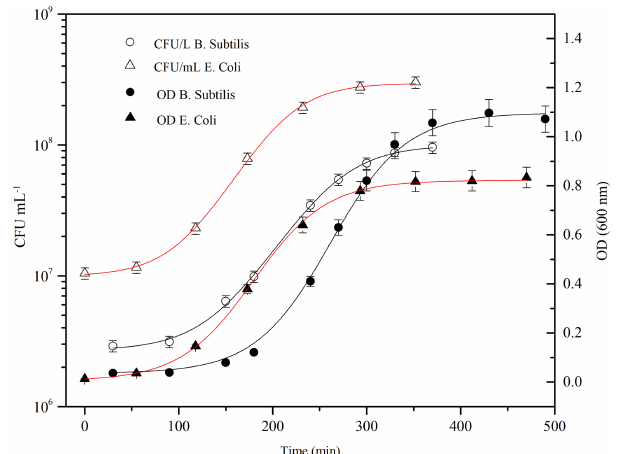
Figure 5. Correlation curve between the number of B. subtilis bac- teria injected in ChAMBRe (in units of 10 7 CFU) and the average count on the four Petri dishes exposed in each